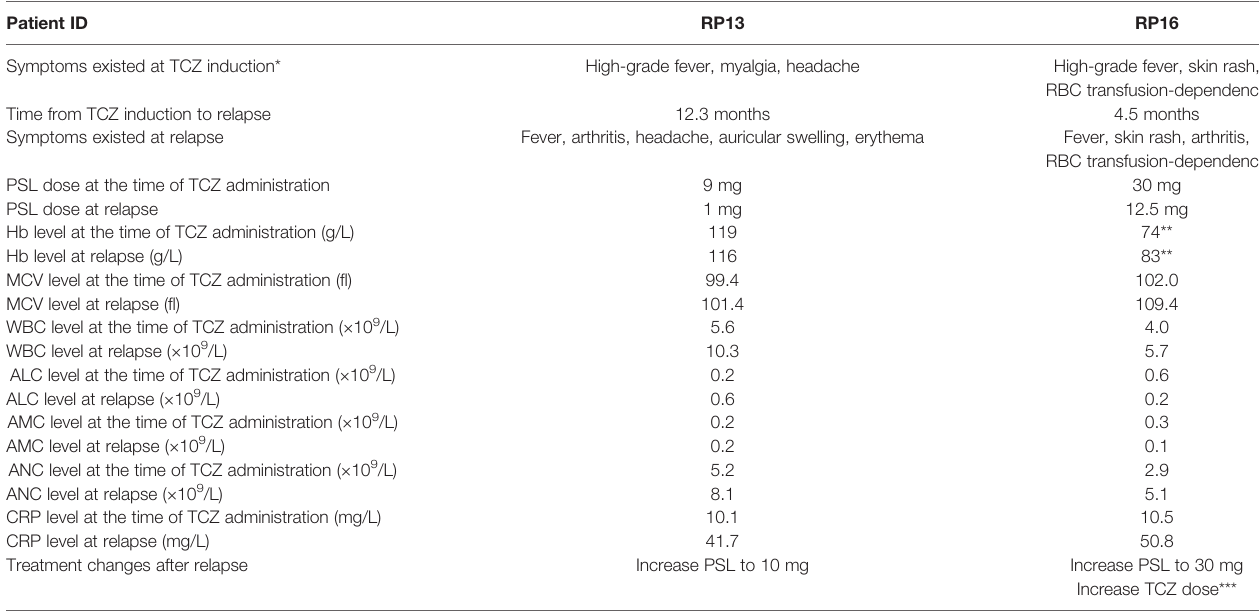
TABLE 2 | Clinical characteristics of the VEXAS-RP patients at relapse. Patient